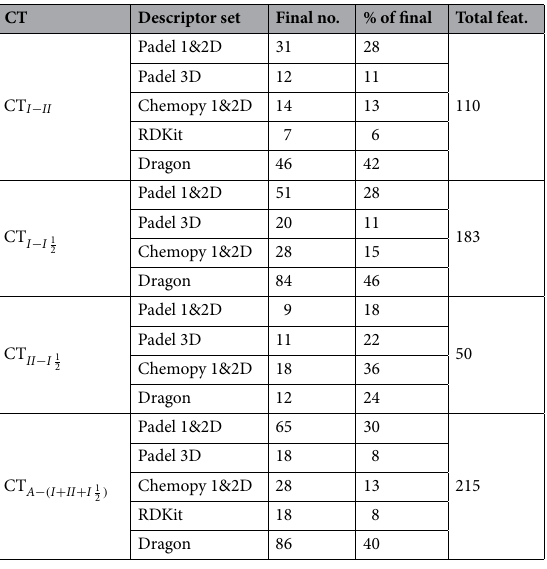
Table 3. Number of selected descriptors from each set in the classification